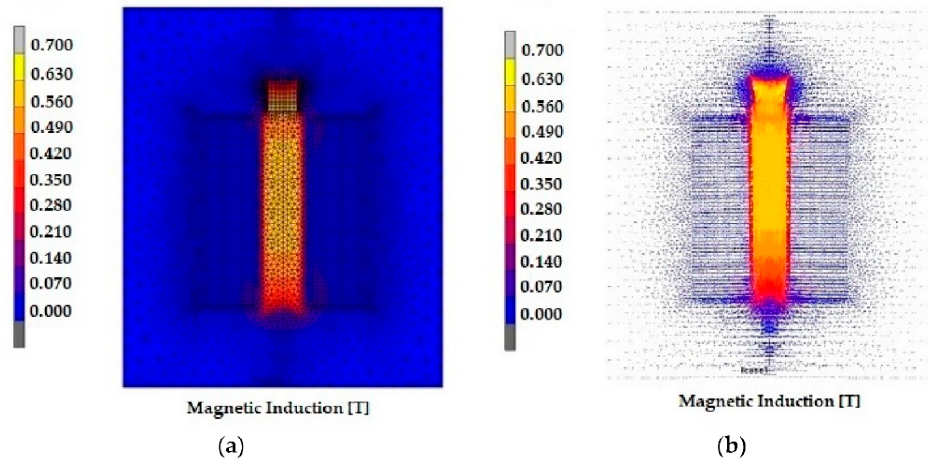
Figure 7. Distribution of magnetic induction on the above configuration of MRE in presence of magnetic field ( a ) with mesh and considering surrounding atmosphere; ( b ) without mesh and using lines of force as external parameter. Reprinted from [18], © 2018 with permission from MDPI.